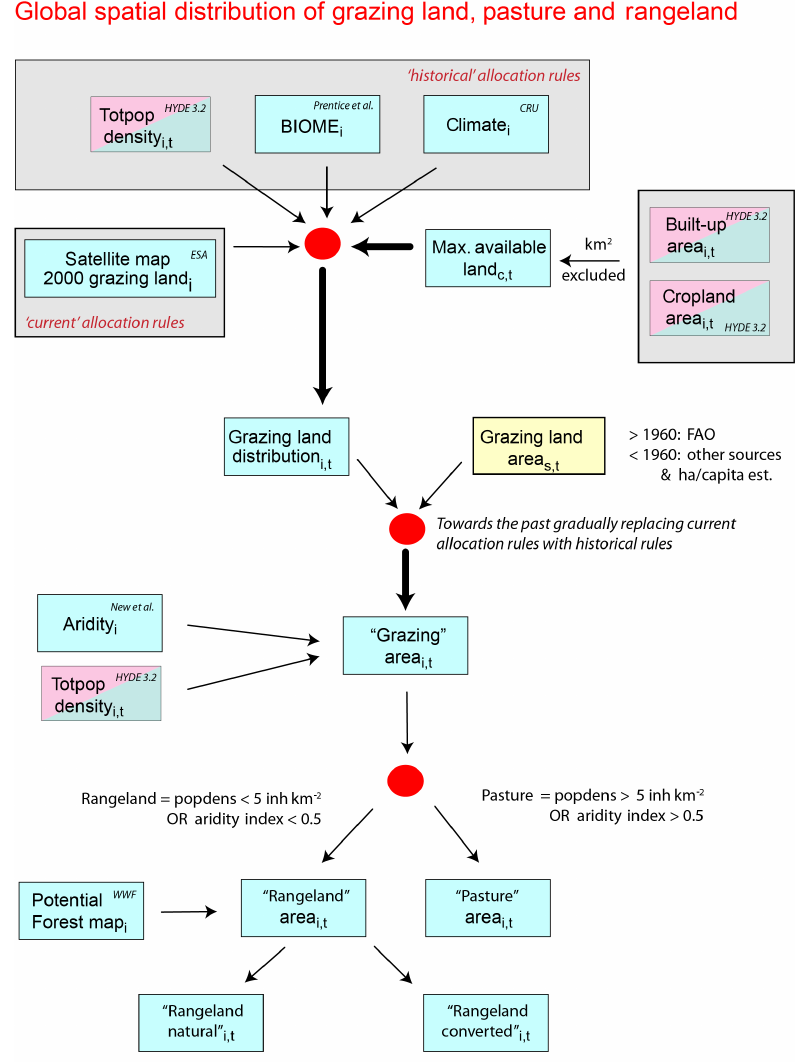
Figure 3. Grazing land allocation